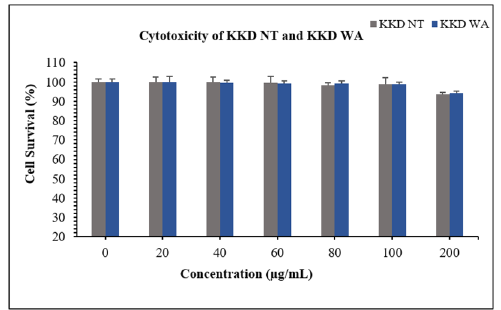
Figure 3 . Cytotoxicity assessment using MTT in HepG2 following the incubation of various concentrations of KKD-NT and KKD-WA for 24 h. Values are mean ± SE of three independent experiments.